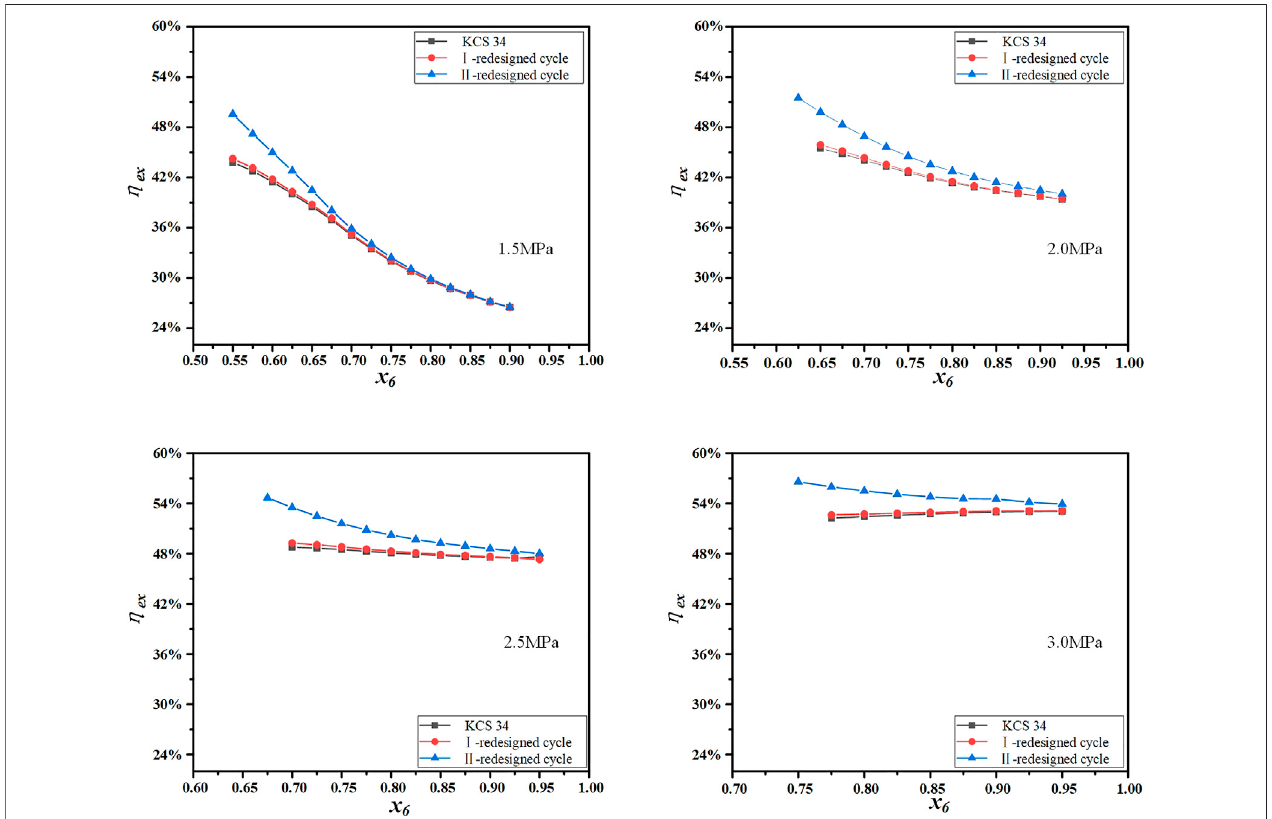
FIGURE 10 | The variation of exergy ef fi ciency with the evaporation pressure and ammonia-water concentration.